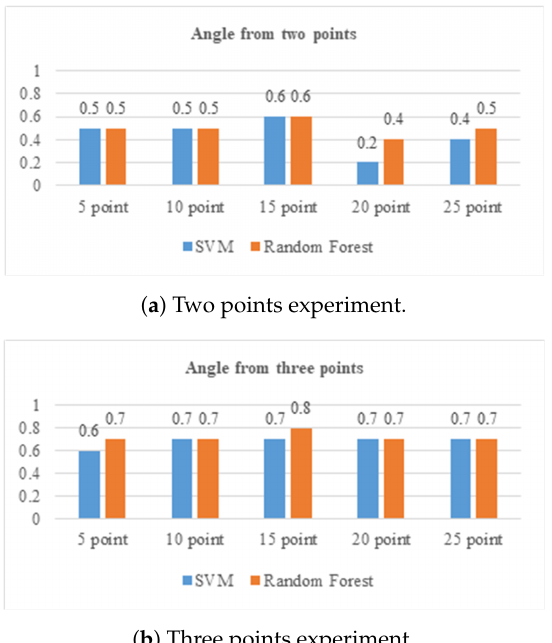
Figure 16. Experiment on data video using two and three